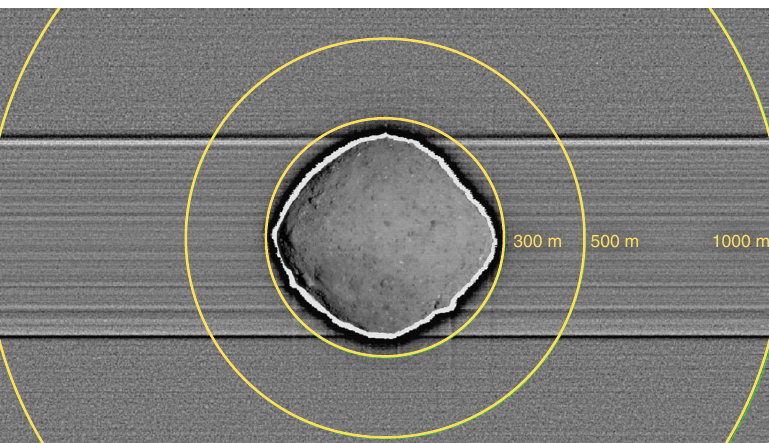
Fig. 1 Satellite-search imaging of the near-asteroid region. The image is a median combination of 15 PolyCam exposures from 10 November 2018 tracking the motion of the asteroid. This method enhances the relative detectability of satellites while suppressing the signal of stars and other background astronomical objects. The yellow circles denote distances from the Bennu center of fi gure. The horizontal features are due to charge smear. No satellites are